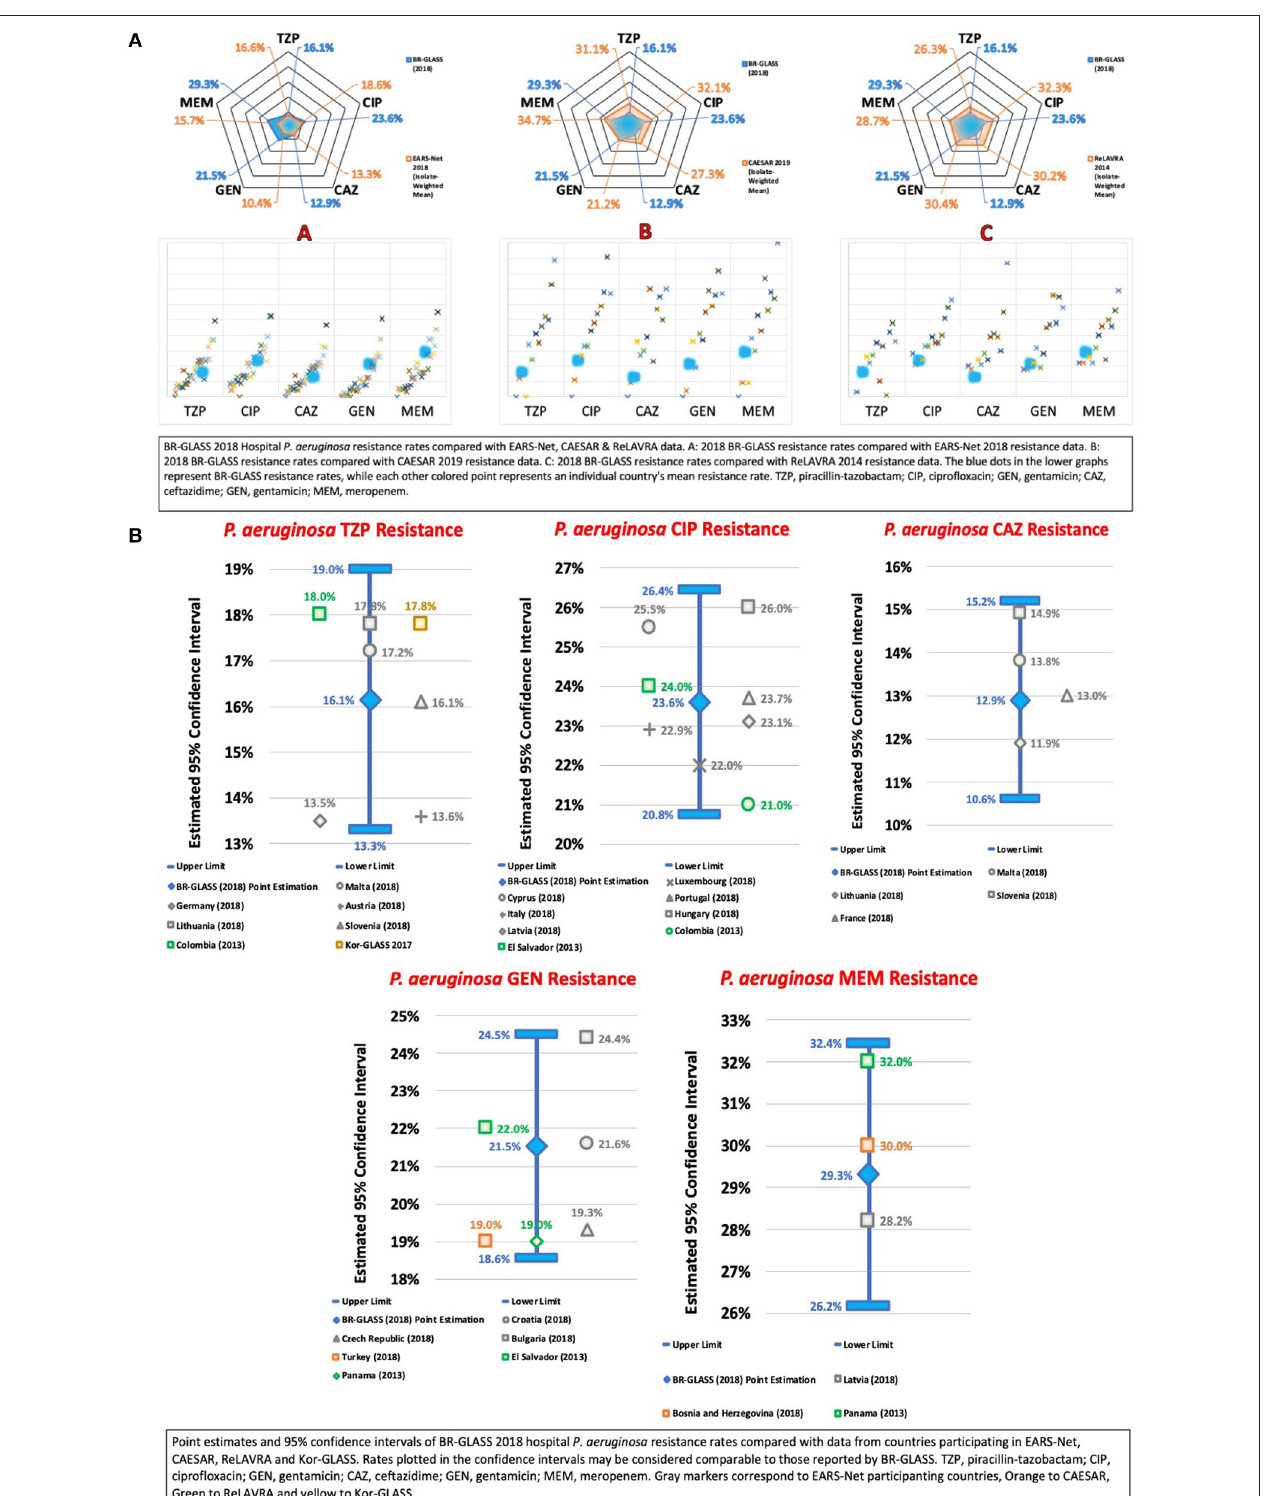
FIGURE 11 | (A) BR-GLASS 2018 Hospital P. aeruginosa resistance rates compared with general EARS-Net, CAESAR, and ReLAVRA data. (B) BR-GLASS 2018 Hospital P. aeruginosa estimated resistance rates with 95% confidence intervals and comparable rates reported in different countries.